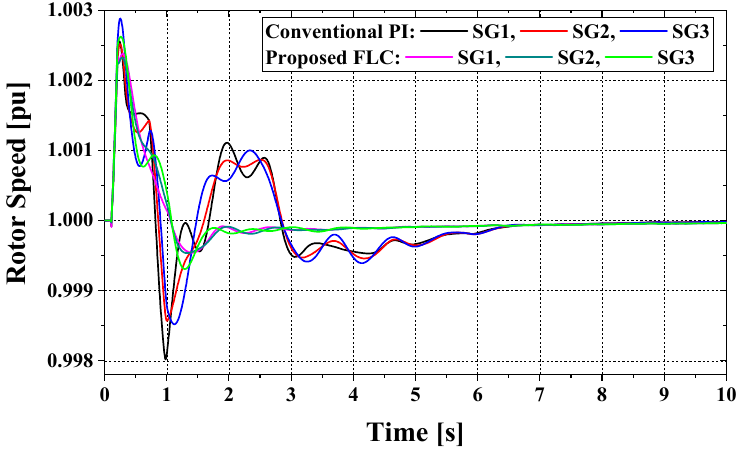
Figure 11. Active power profile of the conventional and proposed PV plants.